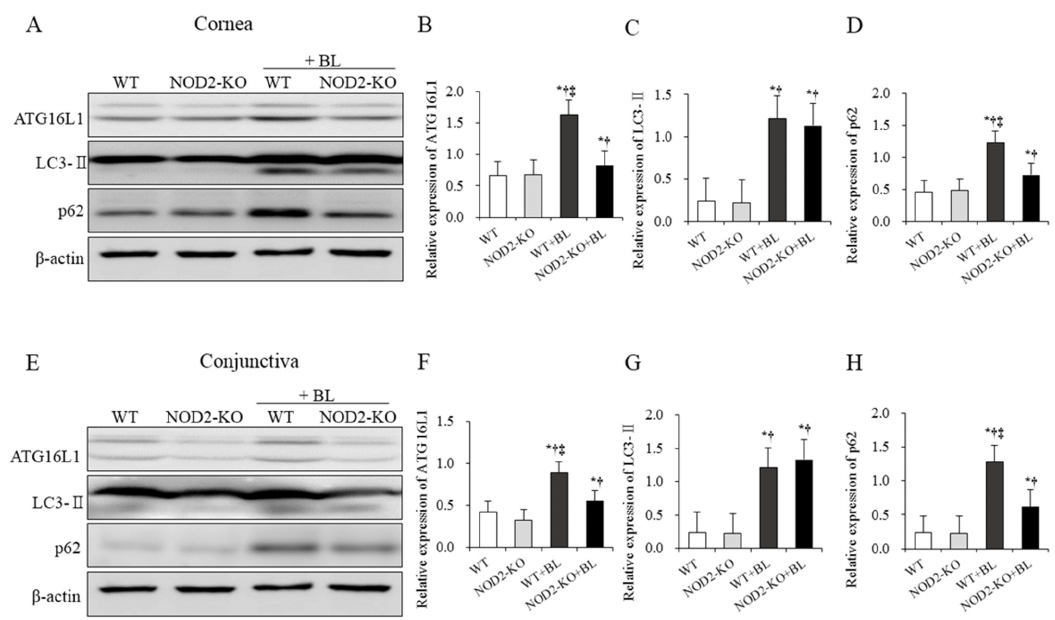
Figure 3. Western blot analysis of autophagy related 16 like 1 (ATG16L1), light chain 3-II (LC3-II), and p62 expression in the WT, NOD2-KO, WT+BL, and NOD2-KO+BL groups after 10 days of blue light exposure. Representative immunoblots of cell lysates showing detection of phosphorylated ATG16L1, LC3-II, and p62 with β -actin loading control in the cornea ( A ) and conjunctiva ( E ). Relative protein expression of ATG16L1, LC3-II, and p62 in the cornea ( B – D ) and conjunctiva ( F – H ). * p < 0.05 vs. WT; † p < 0.05 vs . NOD2-KO; ‡ p < 0.05 vs. WT + BL. WT, wild type; BL, blue light; NOD2-KO, nucleotide-binding oligomerization domain 2 knock-out.